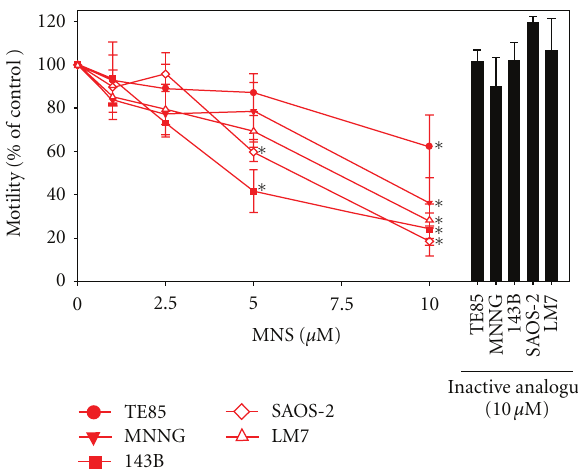
Figure 1: MNS reduced motility in a dose-dependent manner in the osteosarcoma cell lines. Motility was measured 4 hours after scraping in the presence of the indicated concentrations of MNS, 10 μ M of the inactive analogue, or 1% DMSO as a vehicle control. Data are represented as means ± SE of three independent experiments, each with four scrapes per group. Average migration distance for vehicle control groups were 58 μ m for TE85 cells, 41 μ m for MNNG cells, 60 μ m for 143B cells, 26 μ m for SAOS-2 cells, and 18 μ m for LM7 cells. Asterisks denote di ff erences in motility compared with the vehicle control group (10 μ M MNS: TE85 ( P = 0 . 020), MNNG ( P = 0 . 009), 143B ( P < 0 . 001), SAOS-2 ( P < 0 . 001), LM7 ( P = 0 . 001); 5 μ M MNS: 143B ( P < 0 . 001), SAOS-2 ( P = 0 .